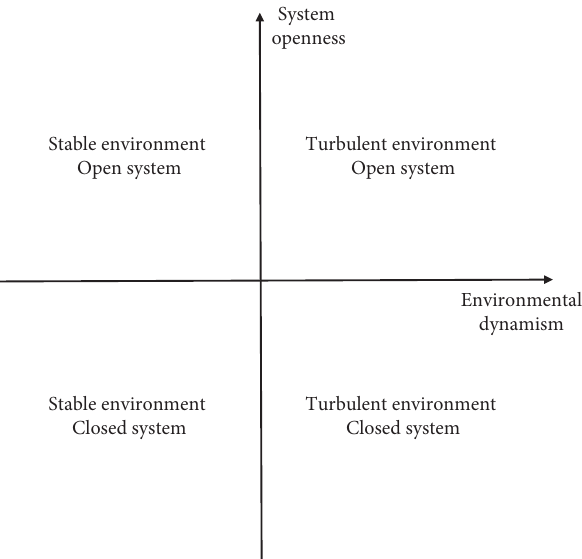
Figure 1: Organizational contexts.